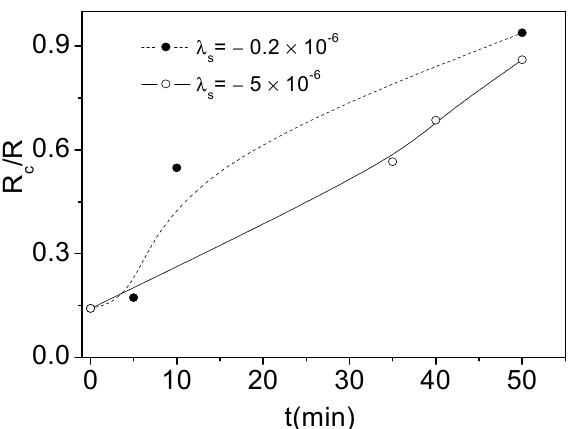
Figure 4. Rc / R ( t ) dependencies for Co 70.5 Mn 4.5 Si 10 B 15 and Co 68.5 Si 14.5 B 14.5 Y 2.5 microwires. The lines are just guides for eyes.